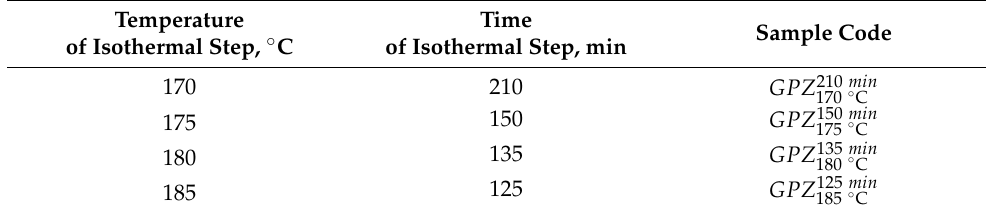
Table 3. Temperature and time of the isothermal steps performed on one of the production batches of glipizide in TG furnace and codes of the recovered solid